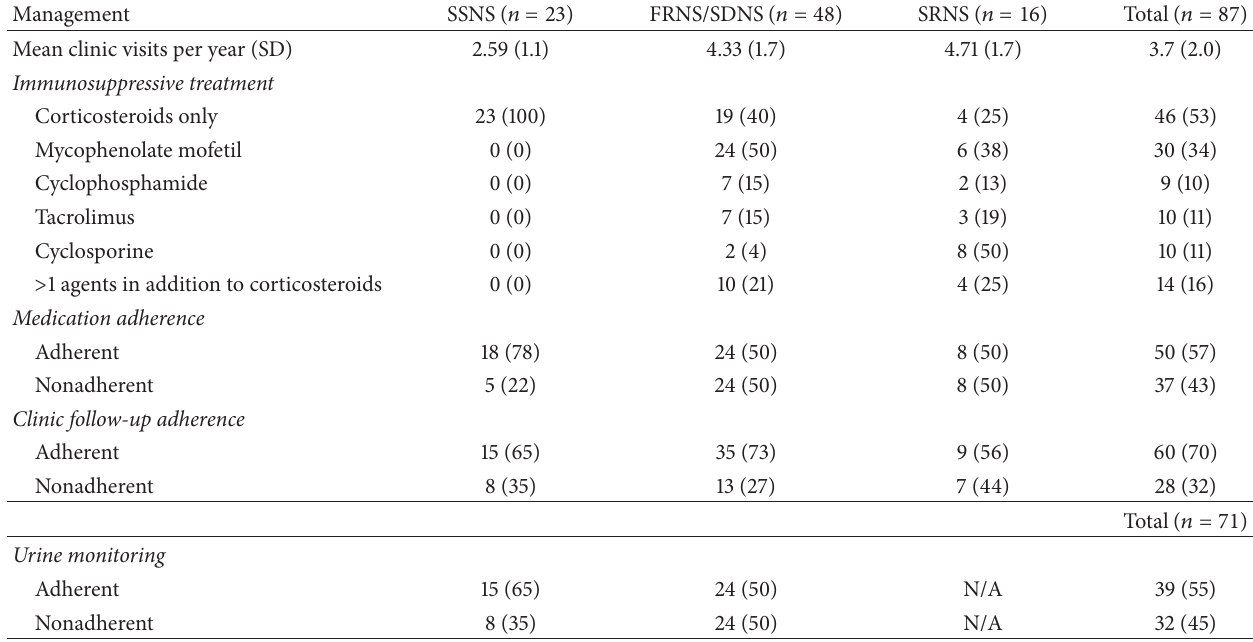
Table 2: Outpatient management and adherence patterns by nephrotic syndrome